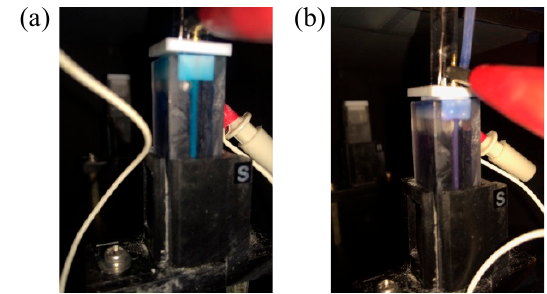
Figure 6. Color change by cyclic voltammetry-UV (CV-UV) measurement: ( a ) Before and ( b ) after the measurement.